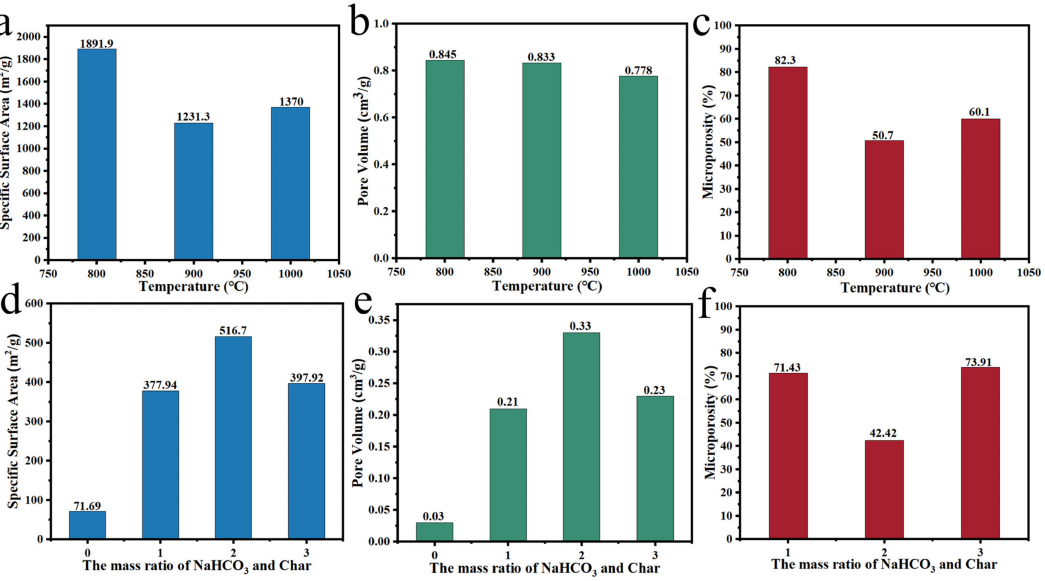
Figure 7. ( a – c ) Impact of temperature on NaHCO 3 activation effect [84]; ( d – f ) Impact of char/alkali mass ratio on NaHCO 3 activation effect